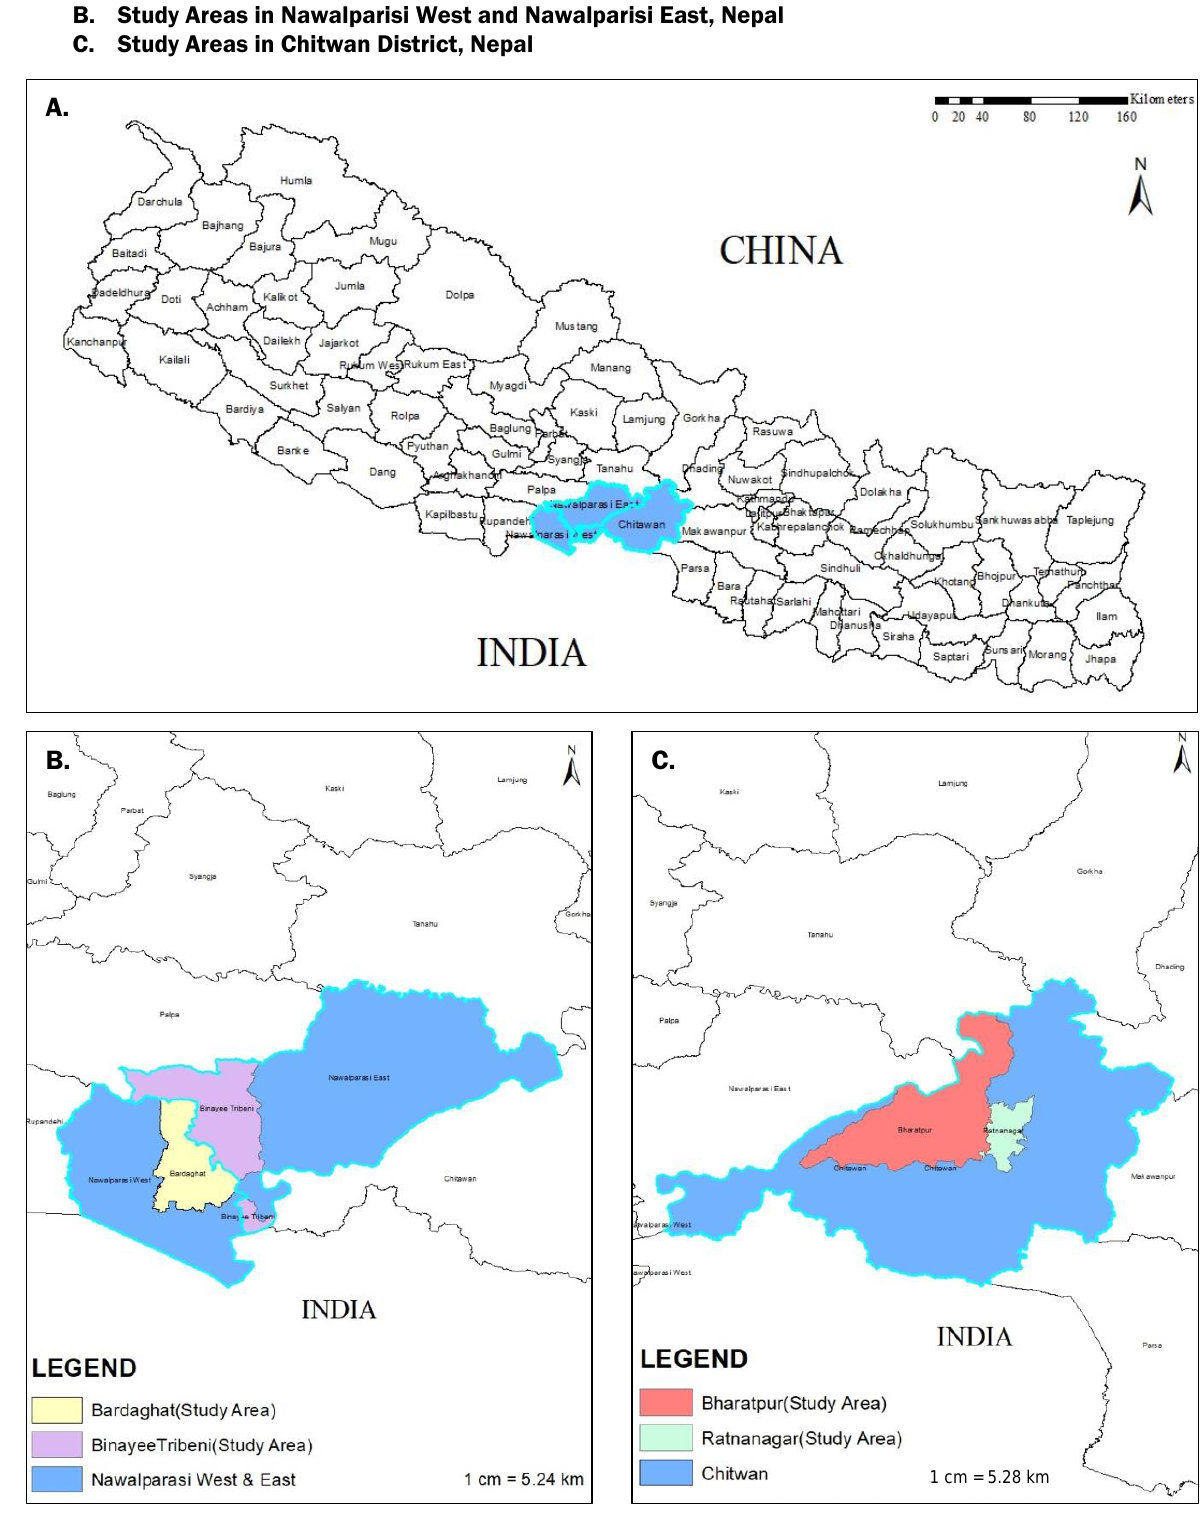
Figure 2. Study Areas A. Study Areas in Nepal (Map prepared by Subodh Gyawali.) B. Study Areas in Nawalparisi West and Nawalparisi East,